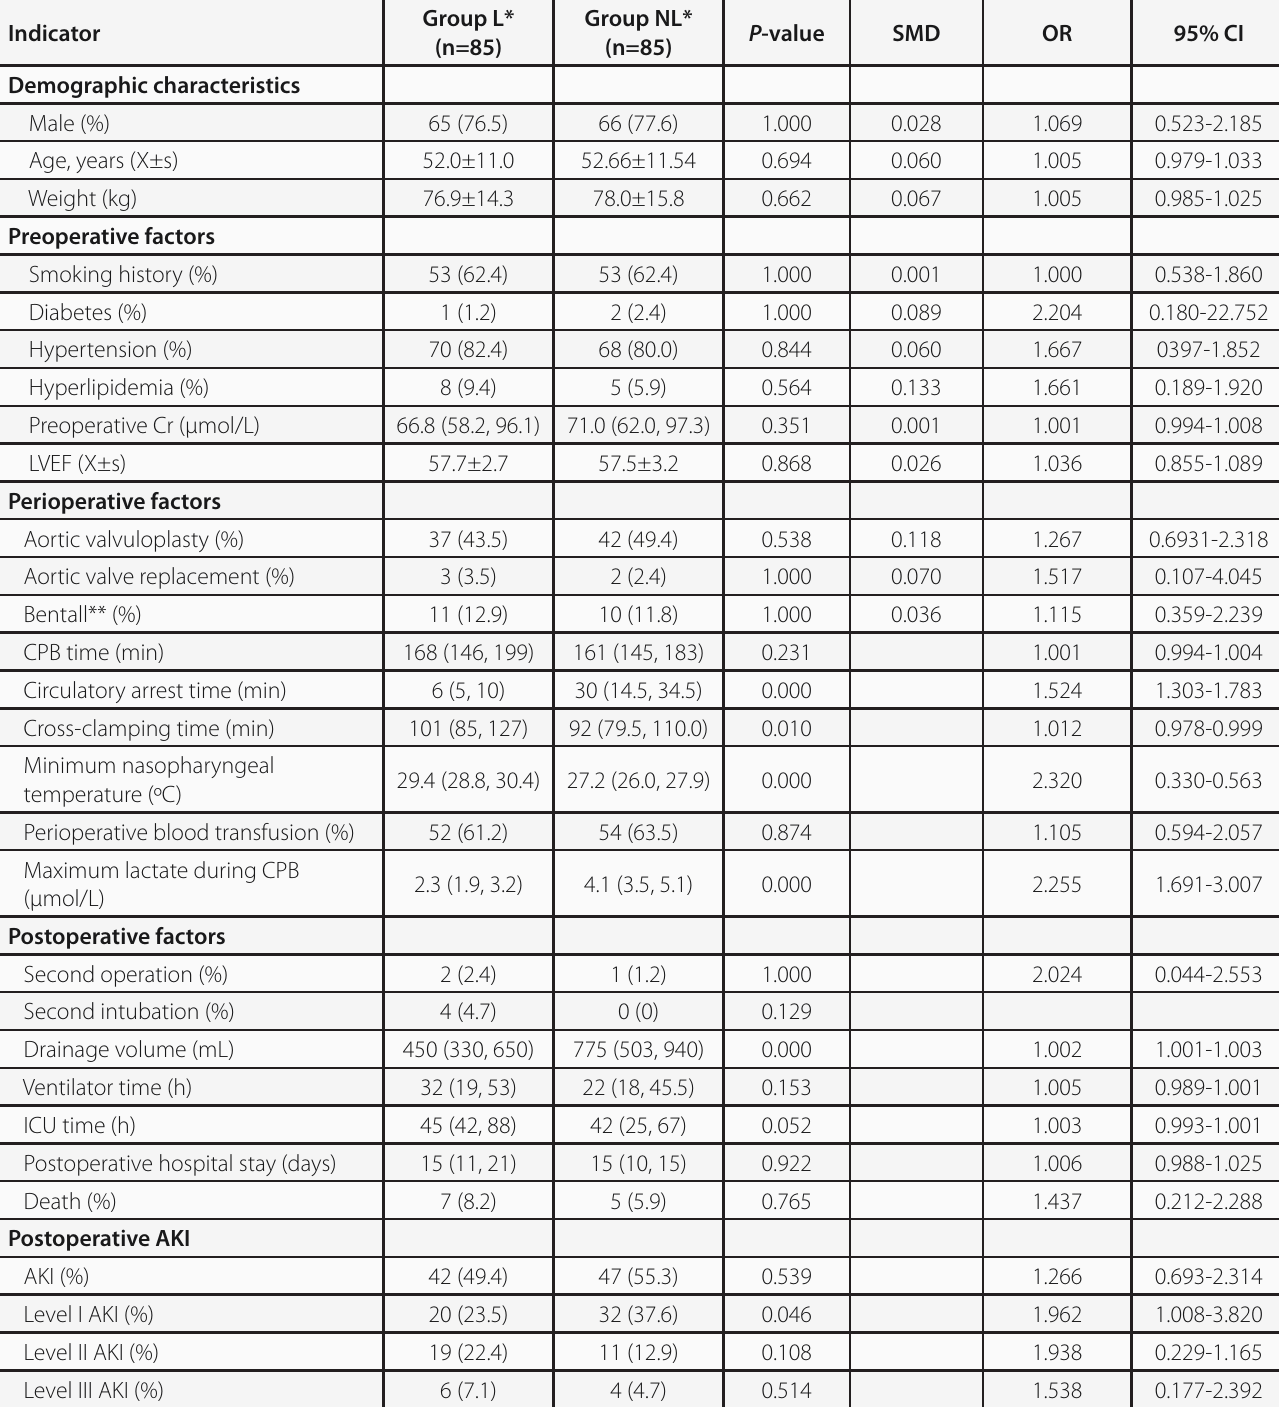
Table 3. Comparison of perioperative influencing factors after